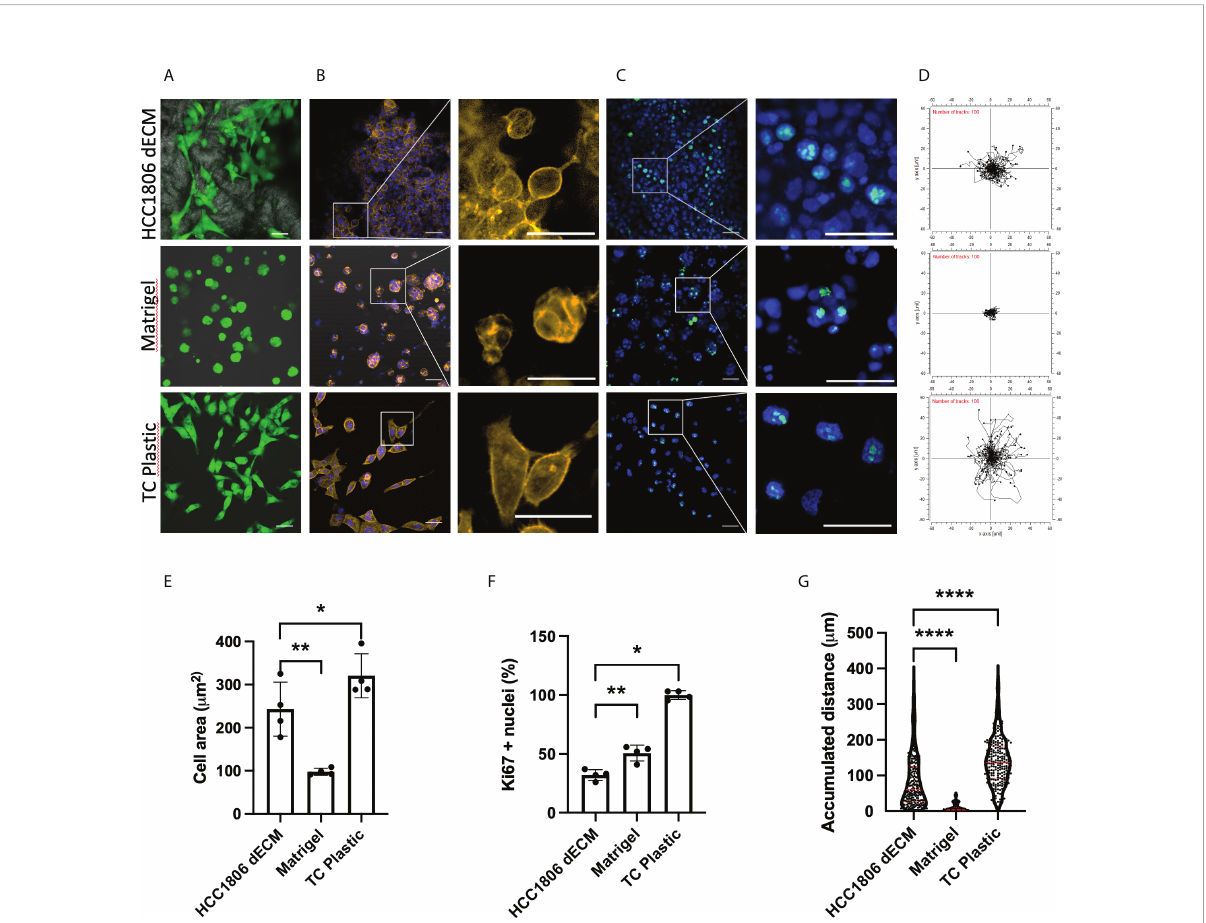
FIGURE 6 HC1806 cells show different cell behaviors on HC1806 dECM compared to other 2D and 3D culture methods. (A – C) Images of cell-seeded samples. (A) Calcein-AM – positive cells are shown in green, while scaffold material is shown in grey (×20 (scale, 20 m m)). (B) Actin cytoskeleton immunostaining in orange; DAPI nuclear staining in blue (×10 (scale, 20 m m) and detailed images (scale, 50 m m)). (C) Ki67 immunostaining in green; DAPI nuclear staining in blue (×10 (scale, 50 m m) and detailed images (scale, 20 m m)). (D) Plotting of the cell displacement during 5 h. Each line represents one cell; 100 cells are provided per plot. The starting point of each cell is provided centered for easy visualization. (E) Quanti fi cation of cell size (area) using actin cytoskeleton membrane distribution images. (F) Quanti fi cation of proliferative cells (Ki67-positive cells vs. total cells observed in each material). (G) Quanti fi cation of cell displacement measured by accumulative distance traveled. N = 3 in all cases and 2 areas measured per